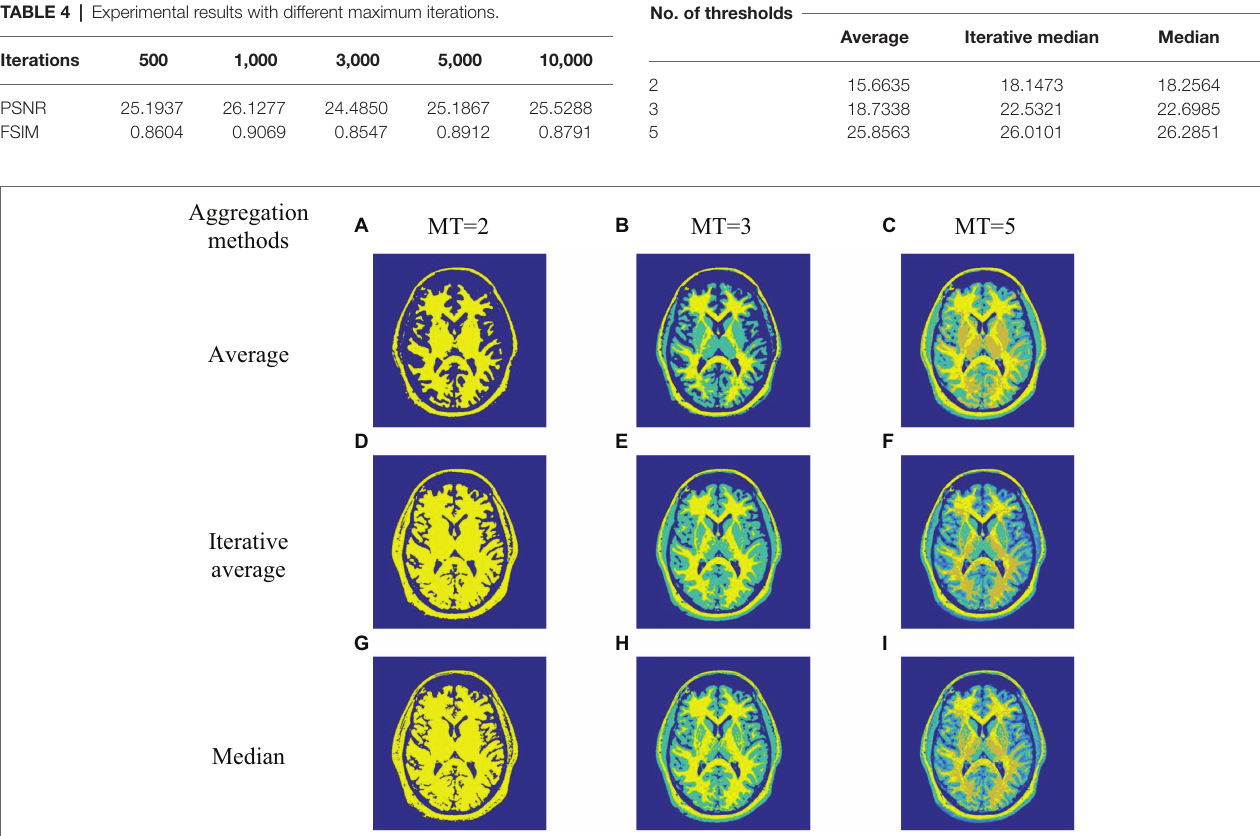
TABLE 4 | Experimental results with different maximum iterations.